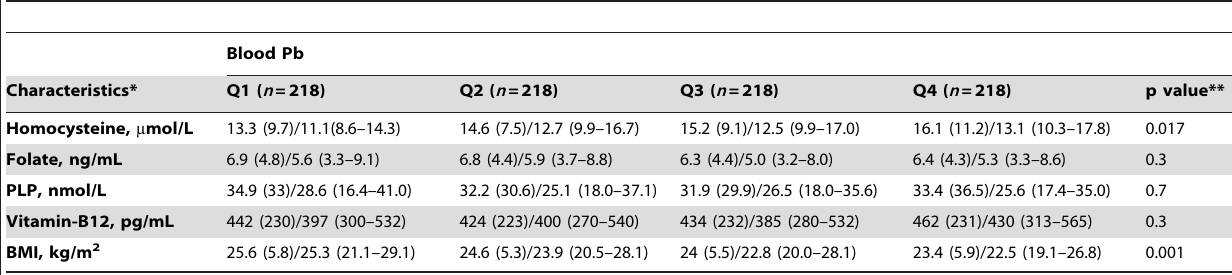
Table 2. Serum/plasma concentrations of homocysteine, folate, PLP, vitamin B12 and BMI, by quartiles of blood Pb in Pakistani